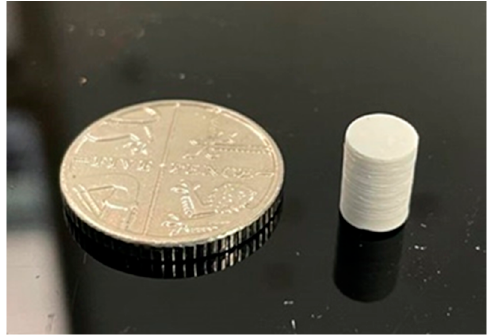
Figure 1. Digital Light Processed green sample.